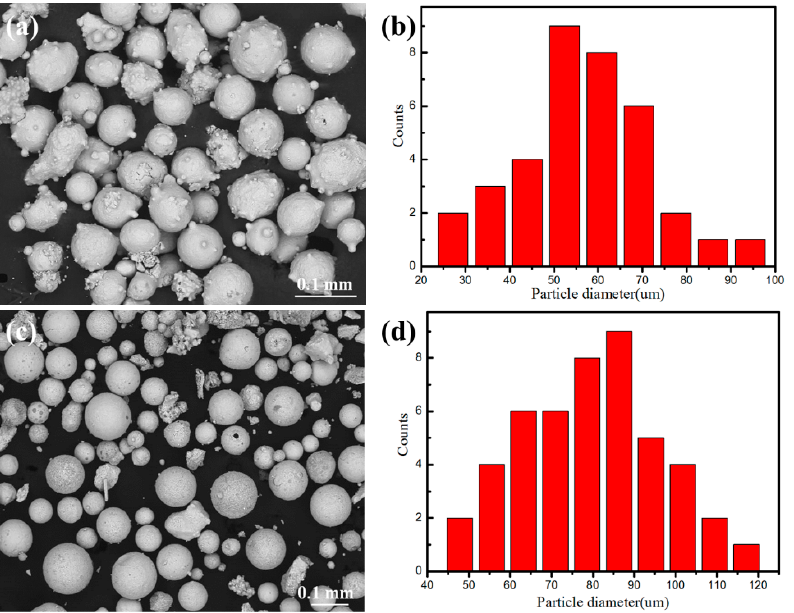
Figure 1. SEM morphology: ( a ) CoCrFeNi HEA powders; ( b ) spherical WC powders; ( c ) the distribution of CoCrFeNi HEA powders; ( d ) the distribution of spherical WC powders. Table 2. Coating numbers with di ff erent WC mass fractions.